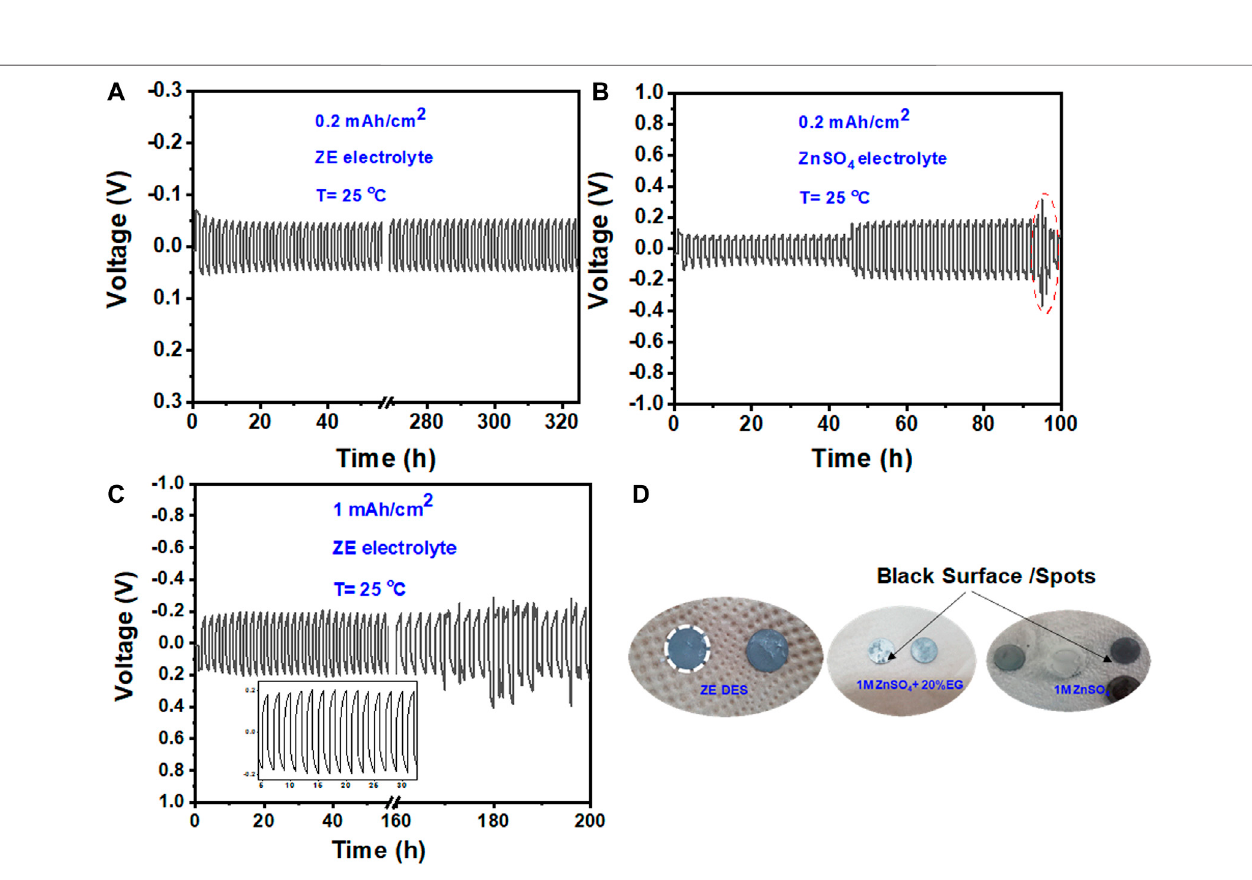
Frontiers in Chemistry |